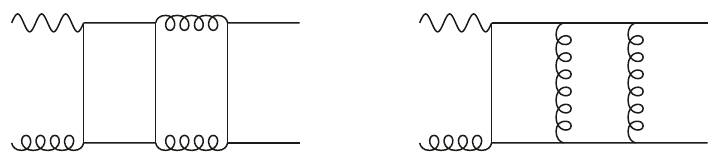
Figure 2 . Example of Feynman diagrams for singlet (left) and non-singlet (right) two-loop massless